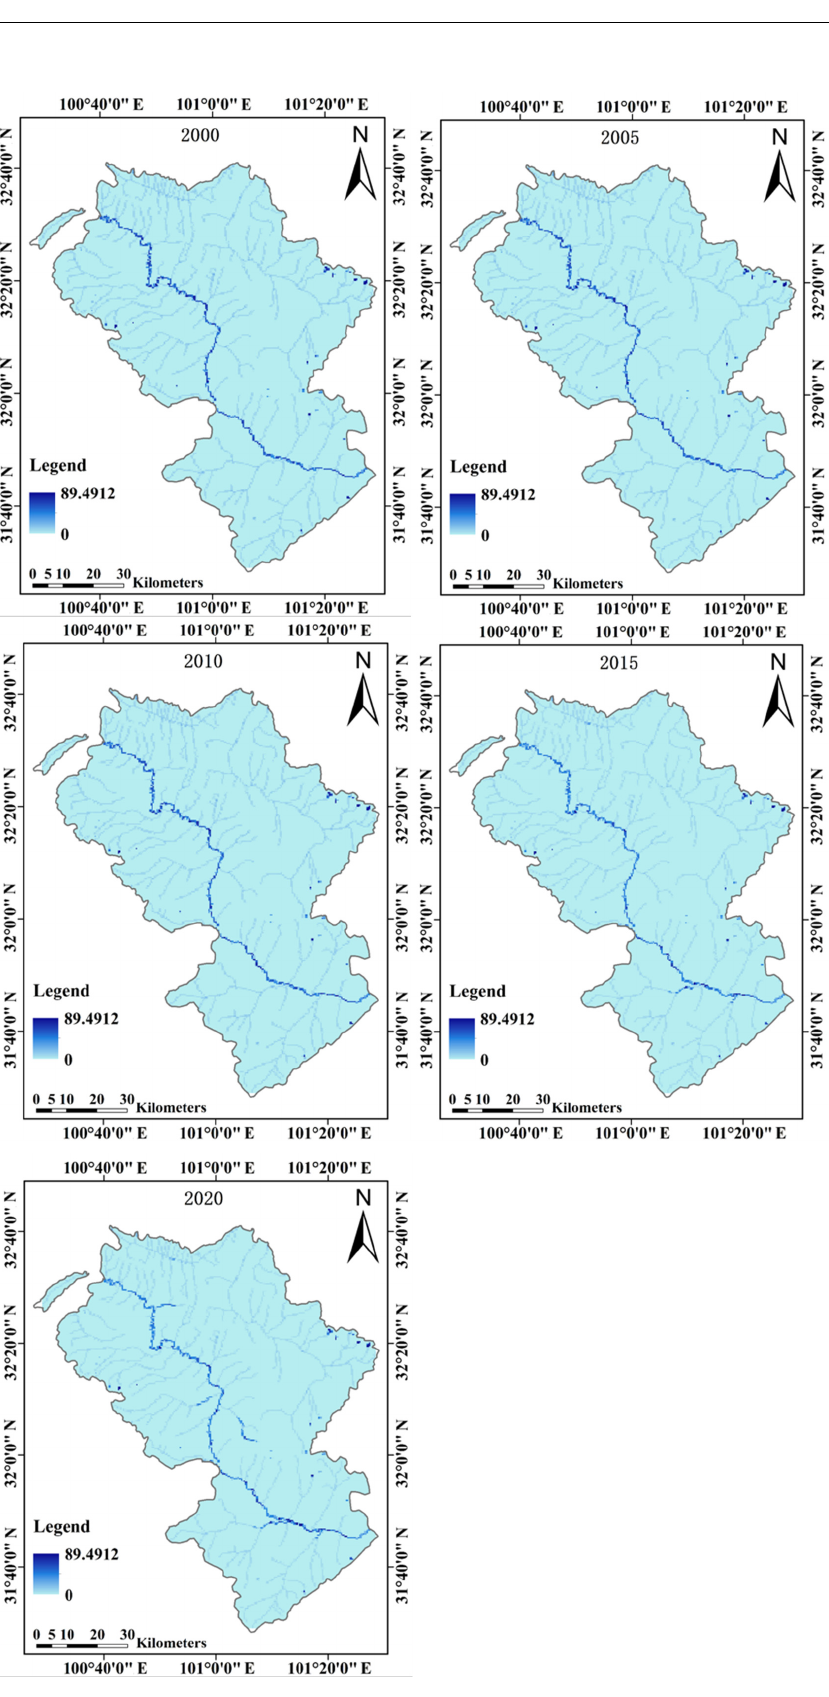
Figure 11. The change of water density index in Rangtang County. The water density index ranges from 0 to 100. The darker the color is, the denser the water is. The large area of 0 value is the reason that the land surface of Rangtang County is mostly covered with vegetation. And that is why there is no water body in the grid. The average water density index was 12.44 in 2000, 12.58 in 2005, 13.37 in 2010, 15.03 in 2015, and 16.42 in 2020. The water distribution in Rangtang county is concentrated, mostly in Duke River and its tributaries. This is related to the topographic and geomorphic charac- teristics of Rangtang County. The index through the river valley is larger than that of the alpine meadow. In general, the water density index of Rangtang County increased by more than 3, that is, the distribution of water resources became obviously better.